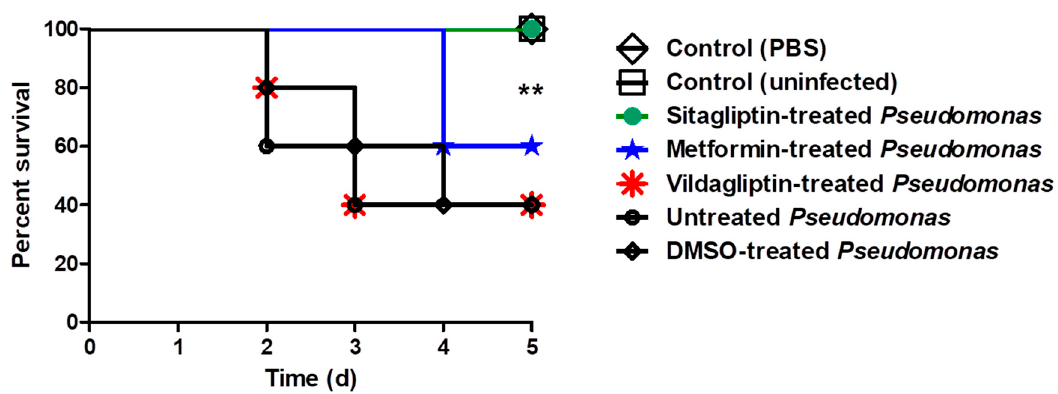
Figure 4. In-vivo protection from P. aeruginosa . Seven groups composed of 5 healthy female mice were used. Group 1, mice were intraperitoneally injected with sitagliptin (sub-MIC) treated P. aeruginosa in sterile phosphate buffer saline (PBS), group 2 were injected with metformin (sub-MIC) treated P. aeruginosa, group 3 were injected with vildagliptin (sub-MIC) treated P. aeruginosa, group 4 was injected with dimethyl sulfoxide (DMSO)-treated P. aeruginosa , group 5 were injected with untreated P. aeruginosa , group 6 were injected with sterile PBS and group 7 were left un-inoculated. Mice survival in each group was recorded every day over 5-days, plotted using the Kaplan–Meier method and significance ( p < 0.05) was calculated using the Log rank test, GraphPad Prism 8. All mice in negative control groups (groups 6 and 7) survived, while only 40% of mice survived (2 out of 5 mice) in the groups comprising metformin treated bacteria, vildagliptin treated bacteria, DMSO-treated bacteria or untreated bacteria. On the other hand, all mice injected with sitagliptin-treated P. aeruginosa survived, showing 100% survival, conferring 60% protection (Log rank test for trend p = 0.0016). **: p ≤ 0.01.